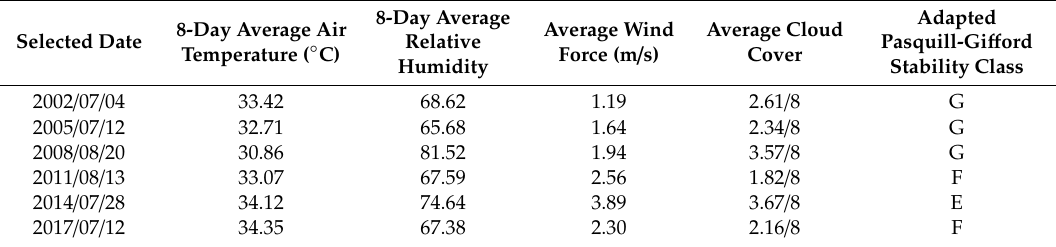
Table 2. Weather information of the selected dominant land surface temperature (LST)